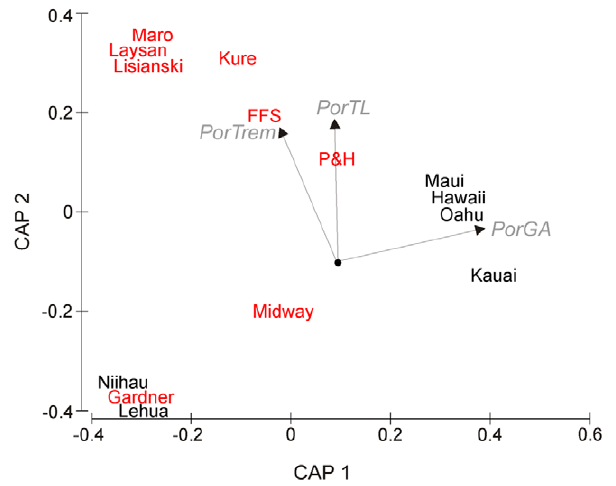
Figure 4. Constrained CAP ordination of coral disease assem- blages for 136 sites at 14 islands across the Hawaiian archipelago. Group centroids are displayed for each island (MHI – black, NWHI – red). Ordination is based on a zero-adjusted Bray-Curtis coefficient. Bi-plot indicates the disease variables (vectors) exerting the strongest influence on the patterns in multivariate space (in grey). The length and direction of each vector indicates the strength and sign, respectively, of the relationship between that disease variable and the CAP axes. Note that Acropora diseases are not included in the analysis. FFS, French Frigate Shoals; P&H, Pearl and Hermes. PorTrem, Porites trematodiasis; PorTL, Porites tissue loss; PorGA, Porites growth anomalies.